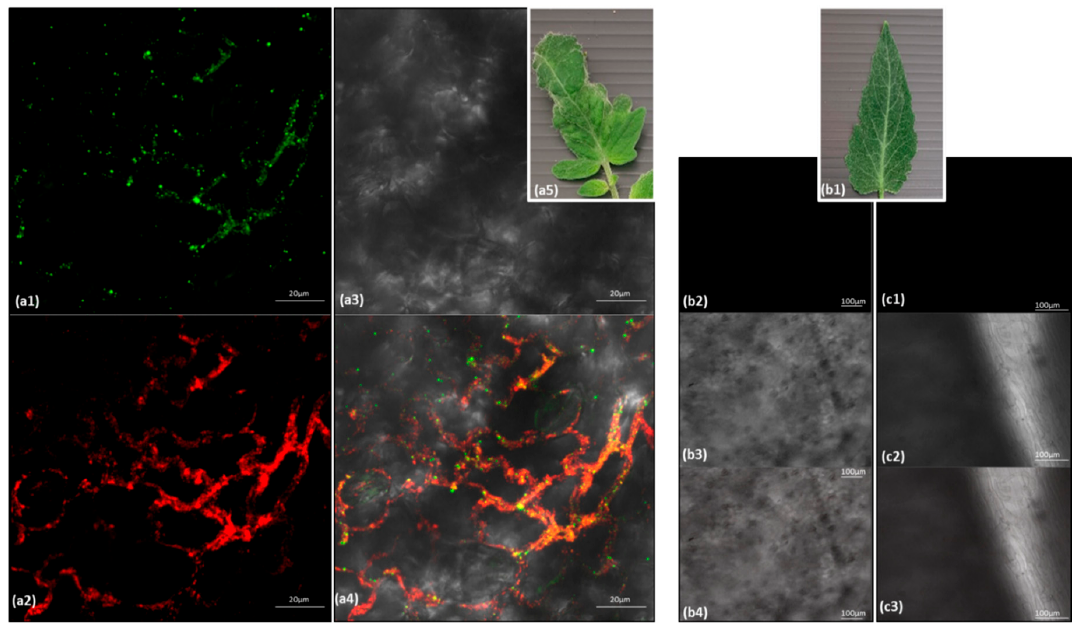
Figure 5. In situ immunofluorescence imaging of tomato brown rugose fruit virus (ToBRFV) and pepino mosaic virus (PepMV) in mixed-inoculated tomato plants. ( a1 ) ToBRFV coat protein (CP) detection in mixed-inoculated tomato plant leaves, using antibodies conjugated to Alexa 488, visualized with a green channel. ( a2 ) PepMV CP detection in mixed-inoculated tomato plant leaves, using antibodies conjugated to Alexa 594, visualized with a red channel. ( a3 ) Mixed-inoculated tomato plant leaves visualized using a bright field. ( a4 ) ToBRFV and PepMV detection in mixed-inoculated tomato plant leaves, using merged channels. ( a5 ) A symptomatic leaf of mixed-inoculated tomato plants, showing mosaic and leaf narrowing and a deformity. ( b1 ) A healthy tomato leaf. ( b2 ) Visualization of a healthy tomato leaf using a green channel. ( b3 ) Visualization of a healthy tomato leaf using a bright field. ( b4 ) Visualization of a healthy tomato leaf using merged channels. ( c1 ) Visualization of a healthy tomato leaf using a red channel. ( c2 ) Visualization of a healthy tomato leaf using a bright field. ( c3 ) Visualization of a healthy tomato leaf using merged channels.